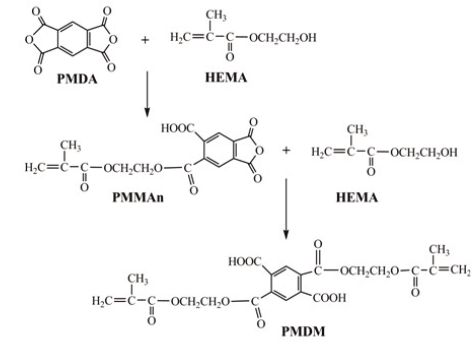
Figure 4: Reaction scheme in PMMAn